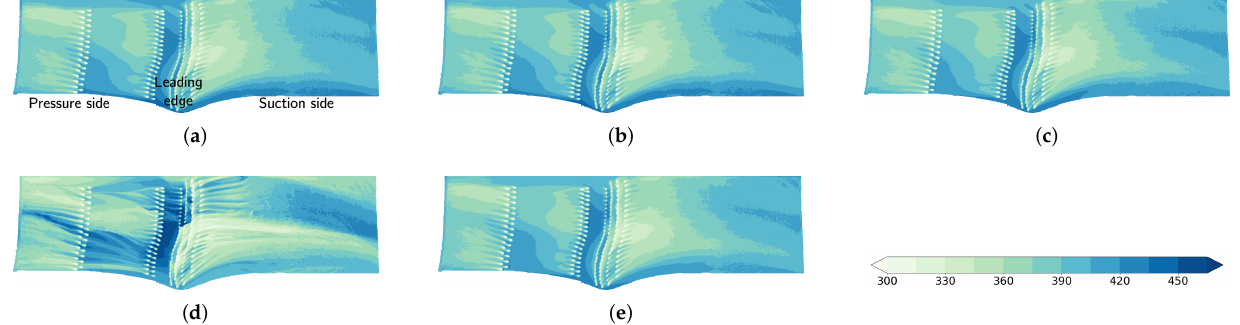
Figure 20. Average adiabatic wall temperature of blade #2 (K). ( a ) Ref. ( b ) F90. ( c ) F65. ( d ) S2. ( e ) T2.